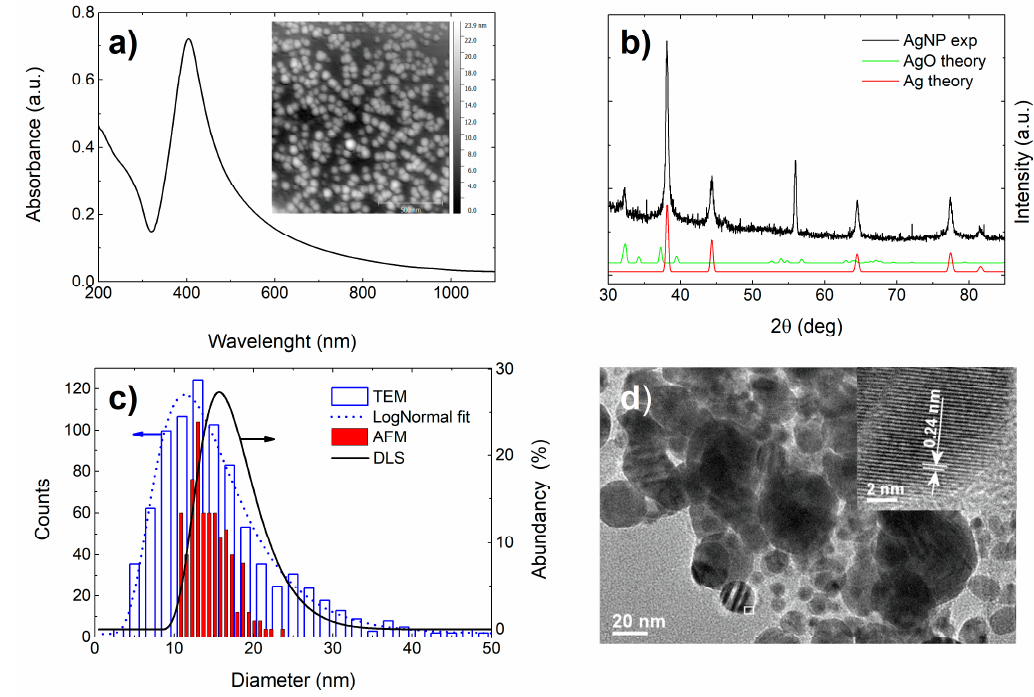
Figure 1. ( a ) UV–VIS photoabsorption spectrum of AgNPs exhibits a prominent characteristic peak at about 400 nm. The inset shows an AFM height image of a dried-out colloid sample reveling spherical shape of AgNPs, ( b ) GIXRD pattern obtained from AgNPs. Simulated patterns for the fcc-Ag and AgO phases are shown at the bottom. The peak at 2 θ = 56 ◦ originates from the monocrystalline silicon substrate, ( c ) Size-distribution of AgNPs obtained from AFM images (red full column bar) with counts multiplied by a factor of 4 for better visibility and from TEM images (blue column bar) with the corresponding log-normal fit (blue dotted curve). The black full curve represents the size distribution obtained from the DLS measurements, ( d ) TEM image of AgNPs. The high-resolution TEM inset indicates the crystalline nature of AgNPs. The inset was taken in the area marked by a white frame.